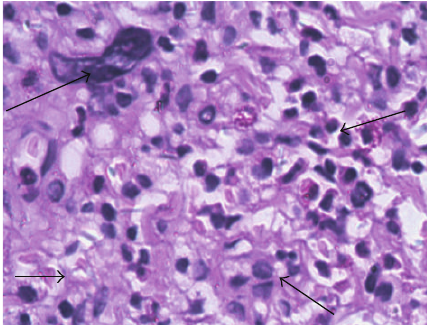
Figure 5: Lymph node biopsy reveals disorganization with myeloid and erythroid precursors among the fat. Several cells show karyoki- nesis (H&E staining 400x). On November 21, 2009, a lymph node biopsy was performed. The left upper arrow showed karyokinesis, the left lower arrow indicated widespread fat cells, the right upper arrow demonstrated erythroblasts, and the right lower arrow sug- gested myeloblast.